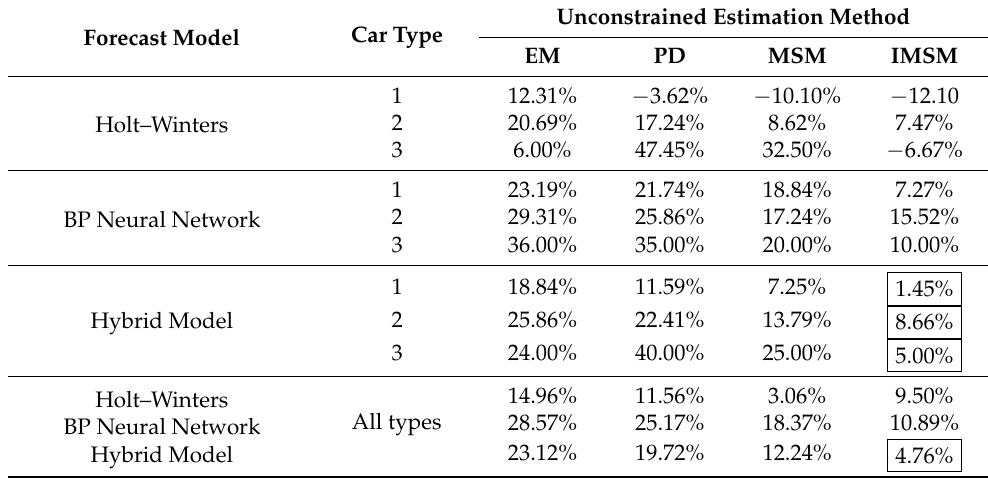
Table 13. Relative errors of forecast demand for each car type and all car